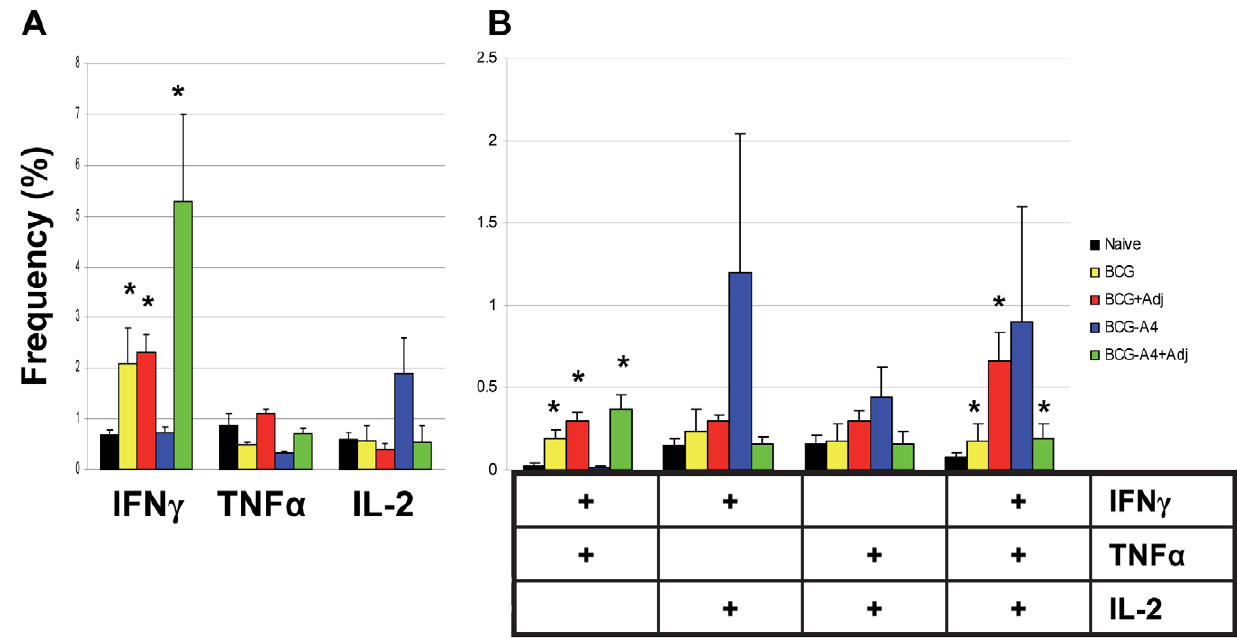
Figure 4. The frequency (%) of (A) monofunctional or (B) multifunctional CD8 T cells in naı¨ve and vaccinated mice as determined by multiparameter flow cytometry analysis. * Statistical significance relative to naives, p , 0.05.